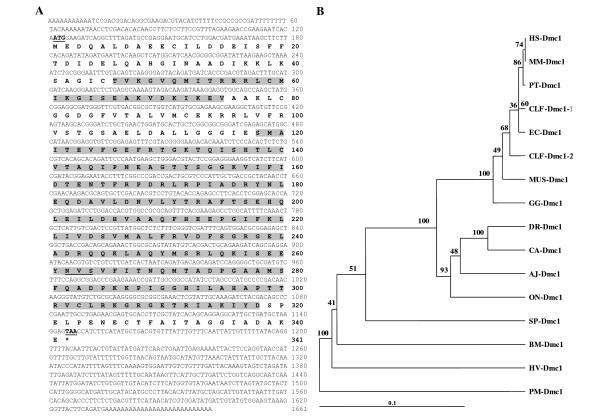
Analysis of Penaeus monodon Dmc1 (PmDmc1). (A) The full-length cDNA and deduced protein sequences of Dmc1 (1,661 bp; ORF 1,026 bp, 341aa) of P. monodon. Start (ATG) and stop (TAA) codons are illustrated in boldface and underlined. The deduced DMC1 protein contains an HhH domain (positions 46-75, E-value = 2.7e-02; highlighted)) and an AAA domain (positions 118-308, E-value = 9.73e-06; highlighted). (B) A bootstrapped neighbor-joining tree illustrating phylogentic relationships of Dmc1 of various taxa. Values at the node represent the percentage of times that the particular node occurred in 1000 trees generated by bootstrapping the original aligned protein sequences. Protein sequences of different isoforms of Dmc1 from Homo sapiens (HS-Dmc1, NM_007068), Equus caballus (EC-Dmc1, XM_001501584), Macaca mulatta (MM-Dmc1, XM_001094012), Pan troglodytes (PT-Dmc1, XM_515130), Canis lupus familiaris (CLF-Dmc1-1, XM_844891 and CLF-Dmc1-2, XM_855217), Gallus gallus (GG-Dmc1, XM_425477), Mus musculus (MM-Dmc1, NM_010059), Anguilla japonica (AJ-Dmc1, AB182645), Oreochromis niloticus (ON-Dmc1, AB182646), Danio rerio (DR-Dmc1, NM_001020782), Carassius auratus (CA-Dmc1, EF545136), Bombyx mori (BM-Dmc1, NM_001044087), Hydra vulgaris (HV-Dmc1, AB047581) and Strongylocentrotus purpuratus (SP-Dmc1, XM_786187), were retrieved from GenBank and compared with Dmc1 of P. monodon (PmDmc1).